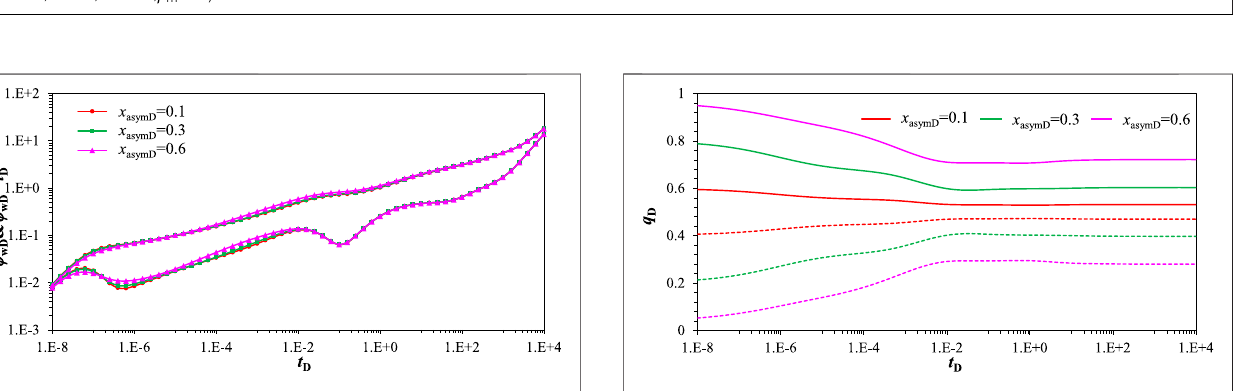
FIGURE9| Pressuretransientresponsecurveeffectedbytheoff-centerdistance.( C D =1e-5, S =0.01, x asymD =0.3, L F =150 m, θ F =90 o , C FD =10, R e =3000 m, ω = 0.1, λ = 1, σ = 0.7, β m = 3).